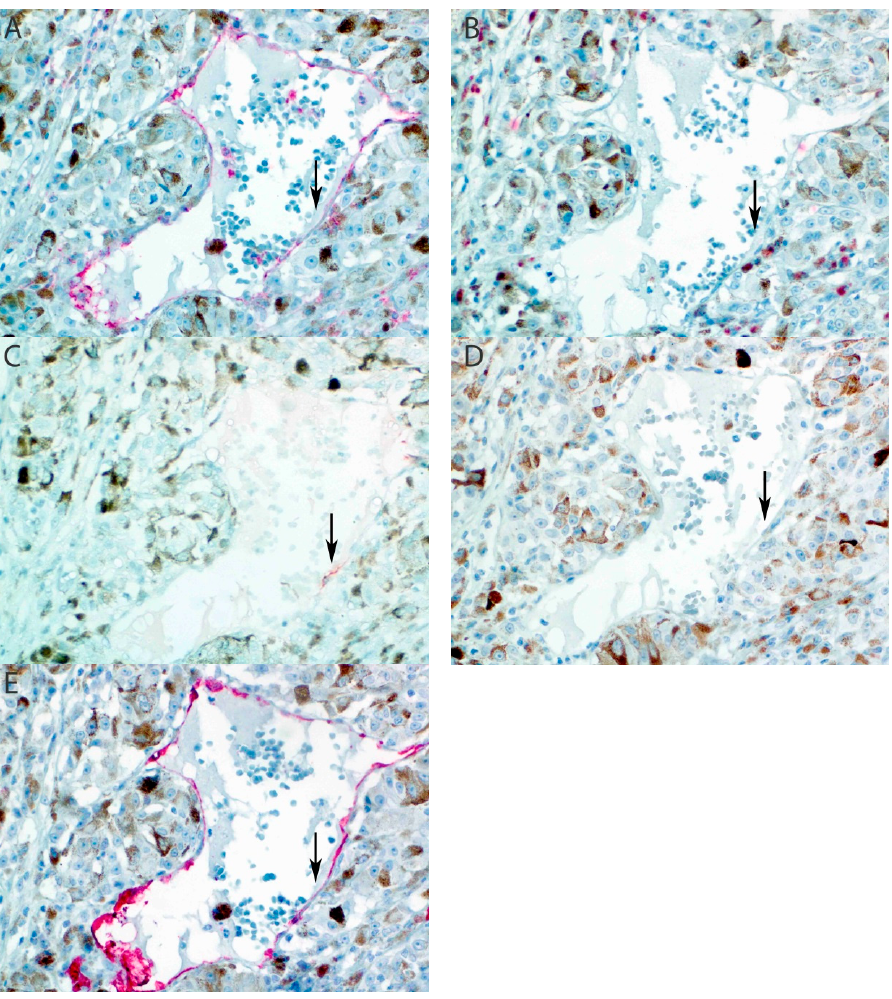
Figure 2. Sample 15 of Table 2: intratumoral focal positive staining of tumor vasculature for LYVE-1. ( A ) CD31 stains all endothelial cells (arrow). ( B ) D2-40 is negative in endothelium. ( C ) LYVE-1 shows focal positive staining in a large tumor vessel. ( D ) Prox-1 is negative. ( E ) CD34 stains all endothelial cells. (All panels: original magnification 400 ×